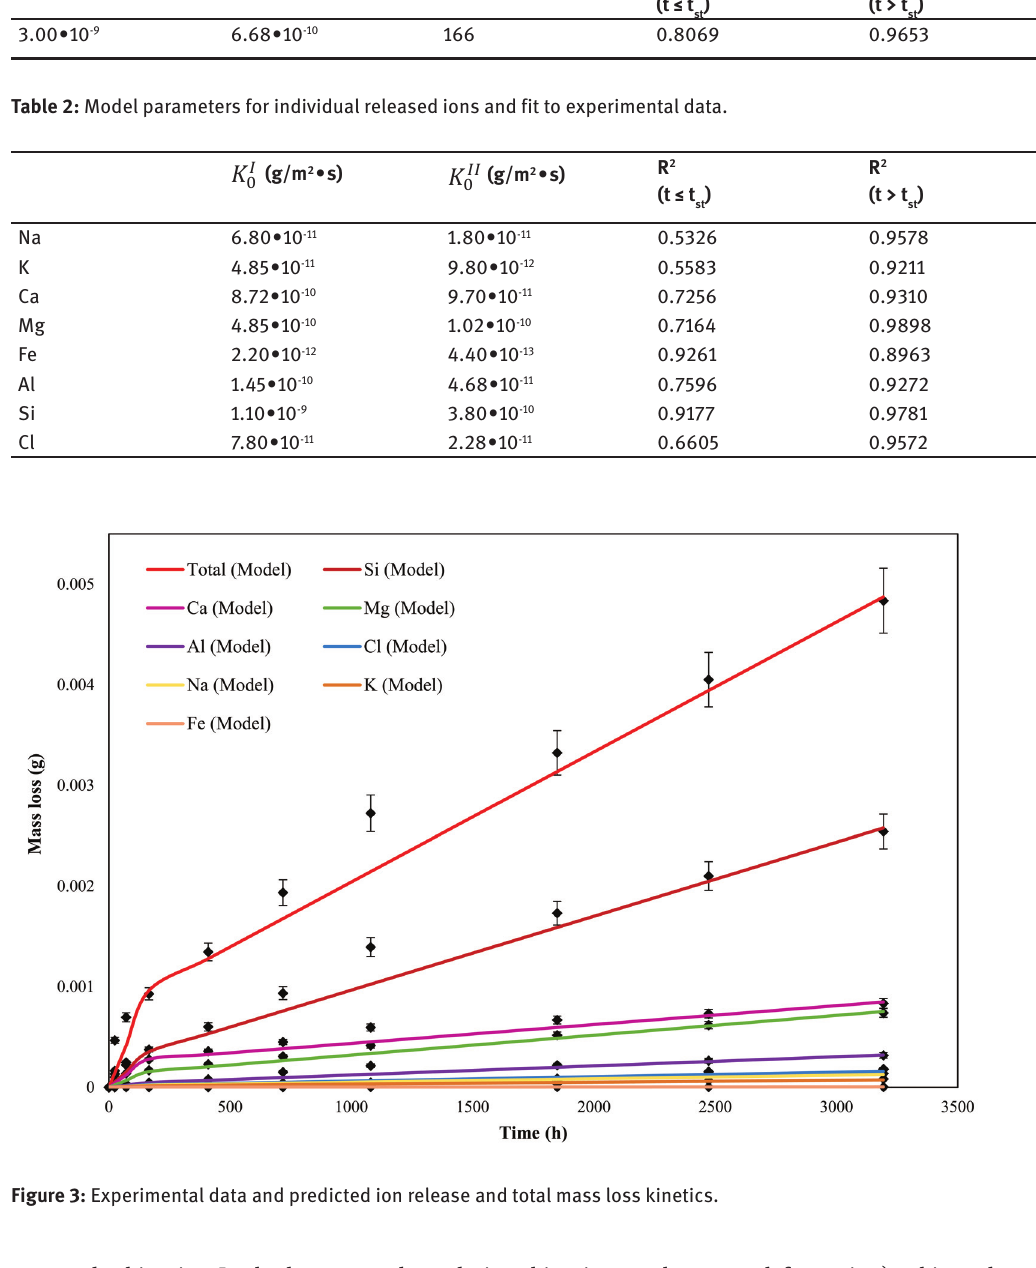
Table 1: Model parameters and fit to experimental data (total mass loss m (cid:1837) (cid:2868)(cid:3010) (g/m 2 ∙s)